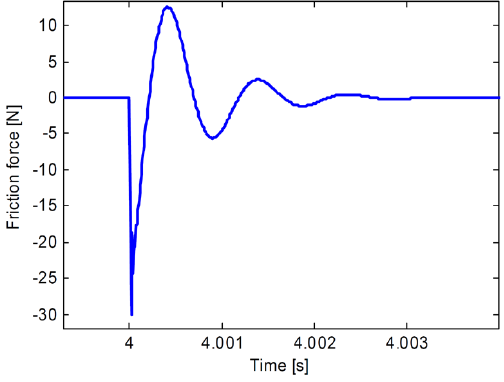
Figure 23. Friction predicted using the elastoplastic model.